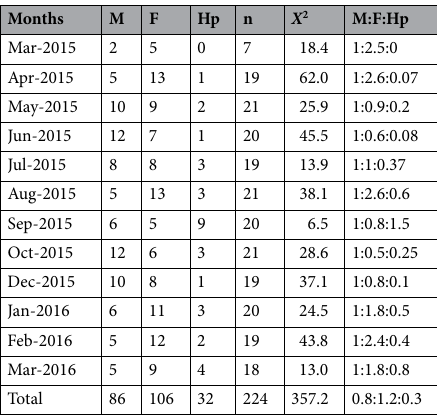
Table 1. Monthly sex ratio for Toxopneustes roseus at Playa Tijera Oaxaca. M males, F females, Hp hermaphrodites, n total individuals analyzed per month.